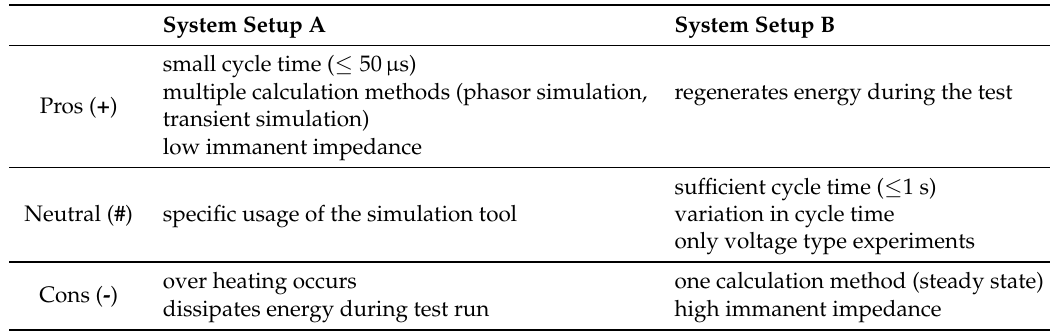
Table 7. Findings of experiments of Phase 0 and Phase